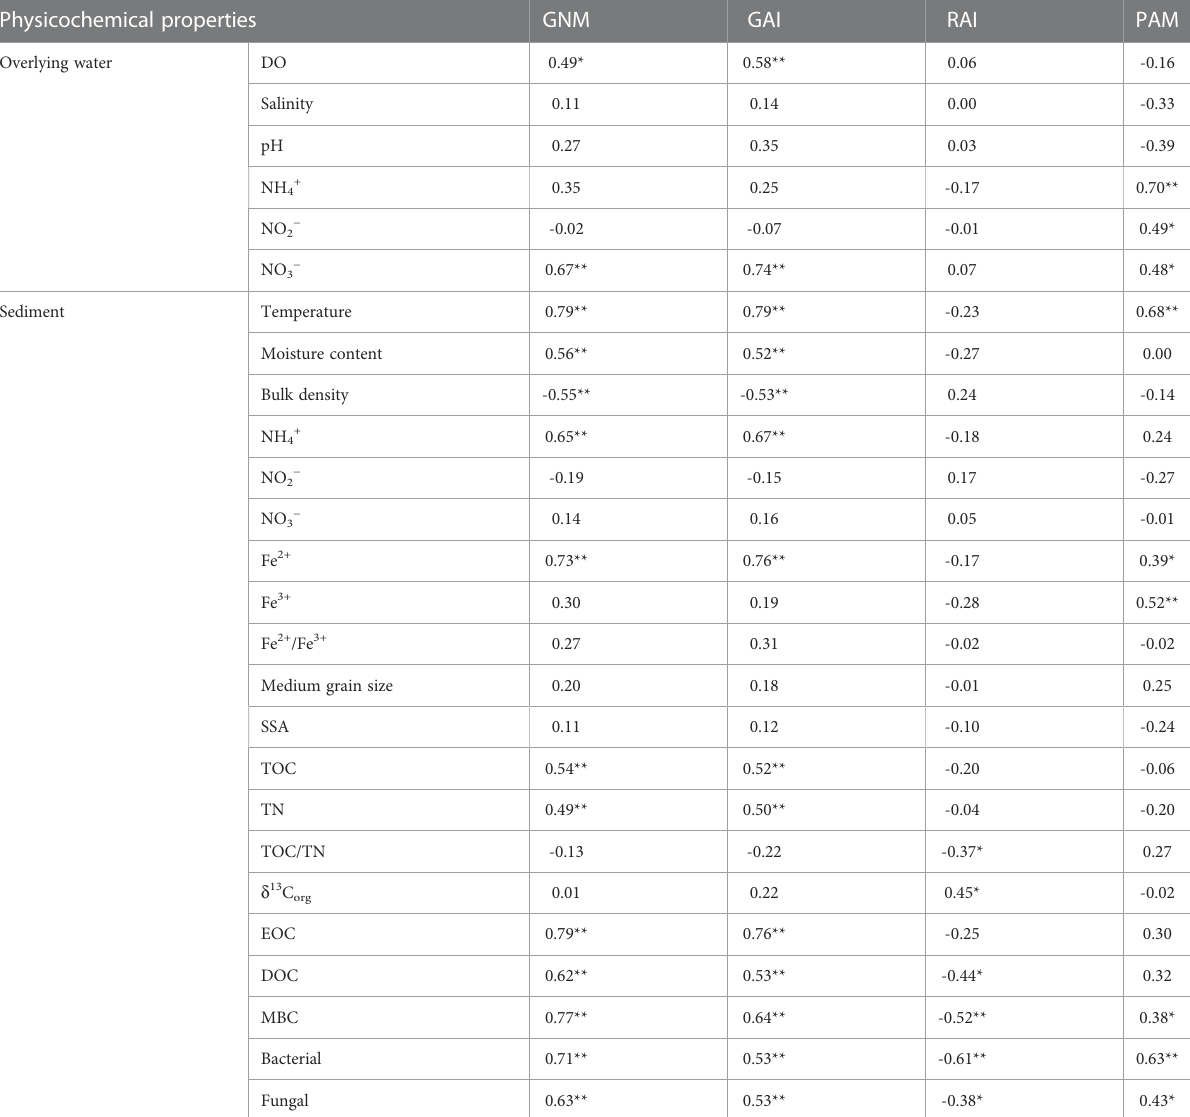
TABLE 3 Correlations between physicochemical properties and N mineralization and immobilization rates. Physicochemical properties Overlying water